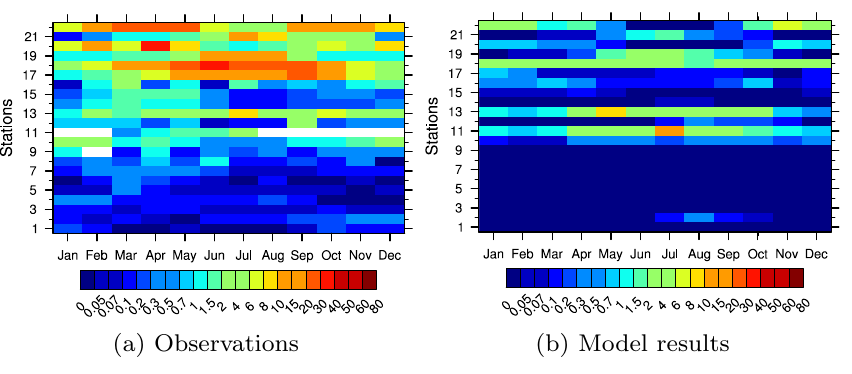
Fig. 5. Monthly averages of measured and simulated dust surface concentrations in µgm − 3 . Observations are considered according to Huneeus et al. (2010). The location of the measurement stations is shown in Fig. 6.